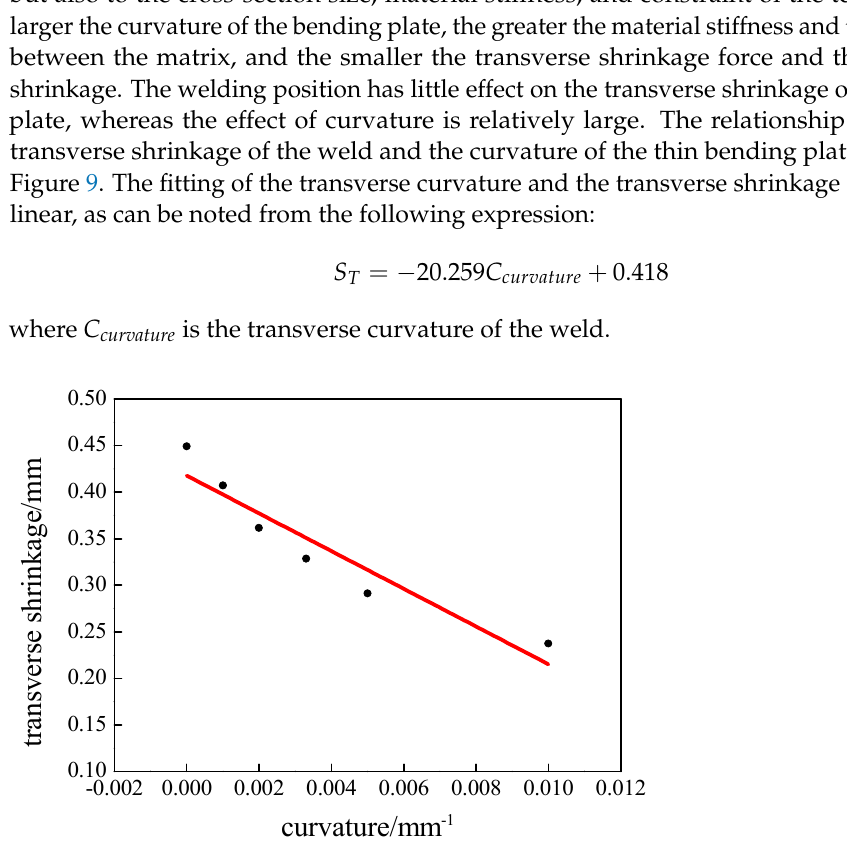
Figure 9. Relationship between curvature and lateral shrinkage of welds. With the increase in the transverse curvature of the thin bending plate (decrease in the radius), the transverse shrinkage of the weld decreases linearly in inverse proportion indicating that the initial transverse bending shape of the thin bending plate greatly affects the transverse shrinkage of the weld after welding deformation. The greater the curvature, the greater the transverse stiffness of the bending plate and the smaller the